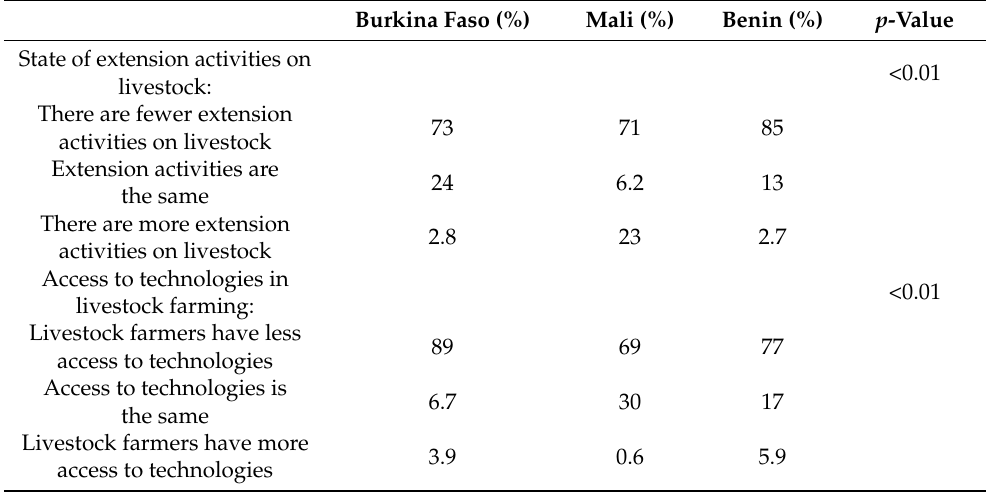
Table 3. Perceptions of respondents in Burkina Faso, Mali, and Benin on provision of extension services relating to livestock production, compared with the provision relating to crop